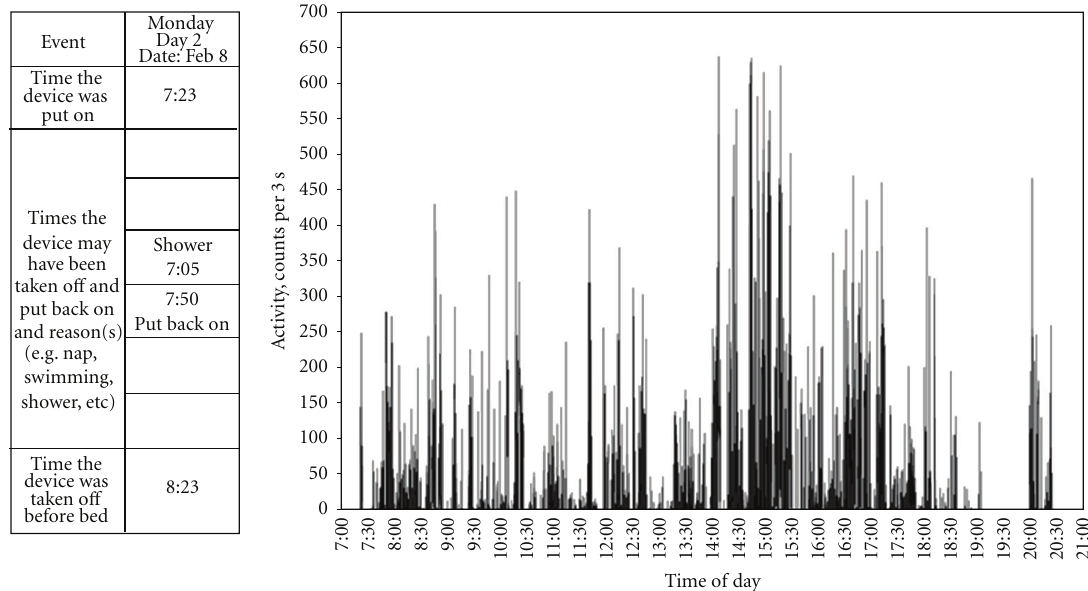
Figure 1: An example of a typical monitoring day for one participant with CP (female, 11 years of age, GMFCS level I). The table is a sample from the participant’s log book in which they were asked to record the times the device was put on and taken o ff for each of the monitoring days. The figure to the right represents the accelerometer output for the corresponding day. No activity was recorded by the device from 7:05 to approximately 7:56 pm, which corresponds to the time the participants indicated they removed the